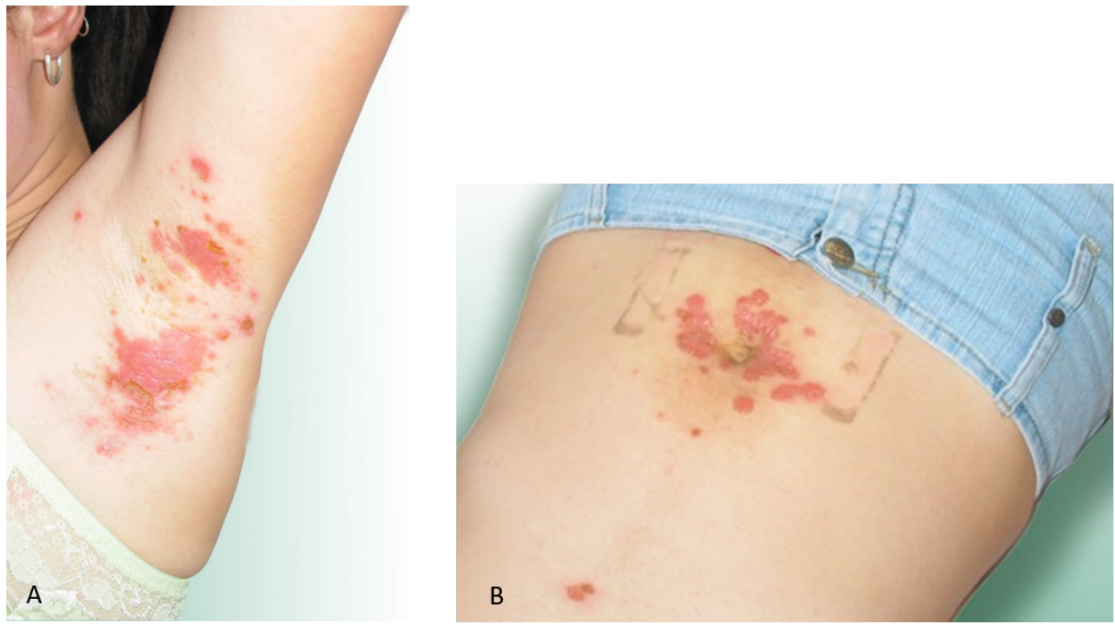
Figure 6. Numerous papules and vesicles. ( A ) in the axillary region and ( B ) on the abdomen, both with secondary bacterial infection in a female patient attacked by blackflies for the first time (case